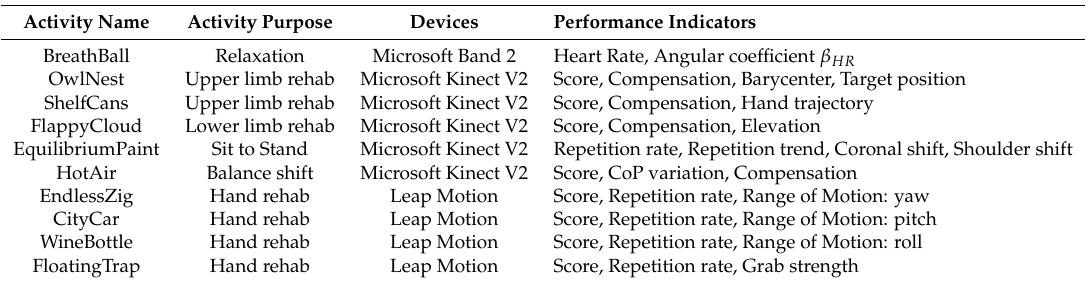
Table 2. Serious games list including the purpose of the activity, the employed devices, and the indicators that describe the patient performance during the